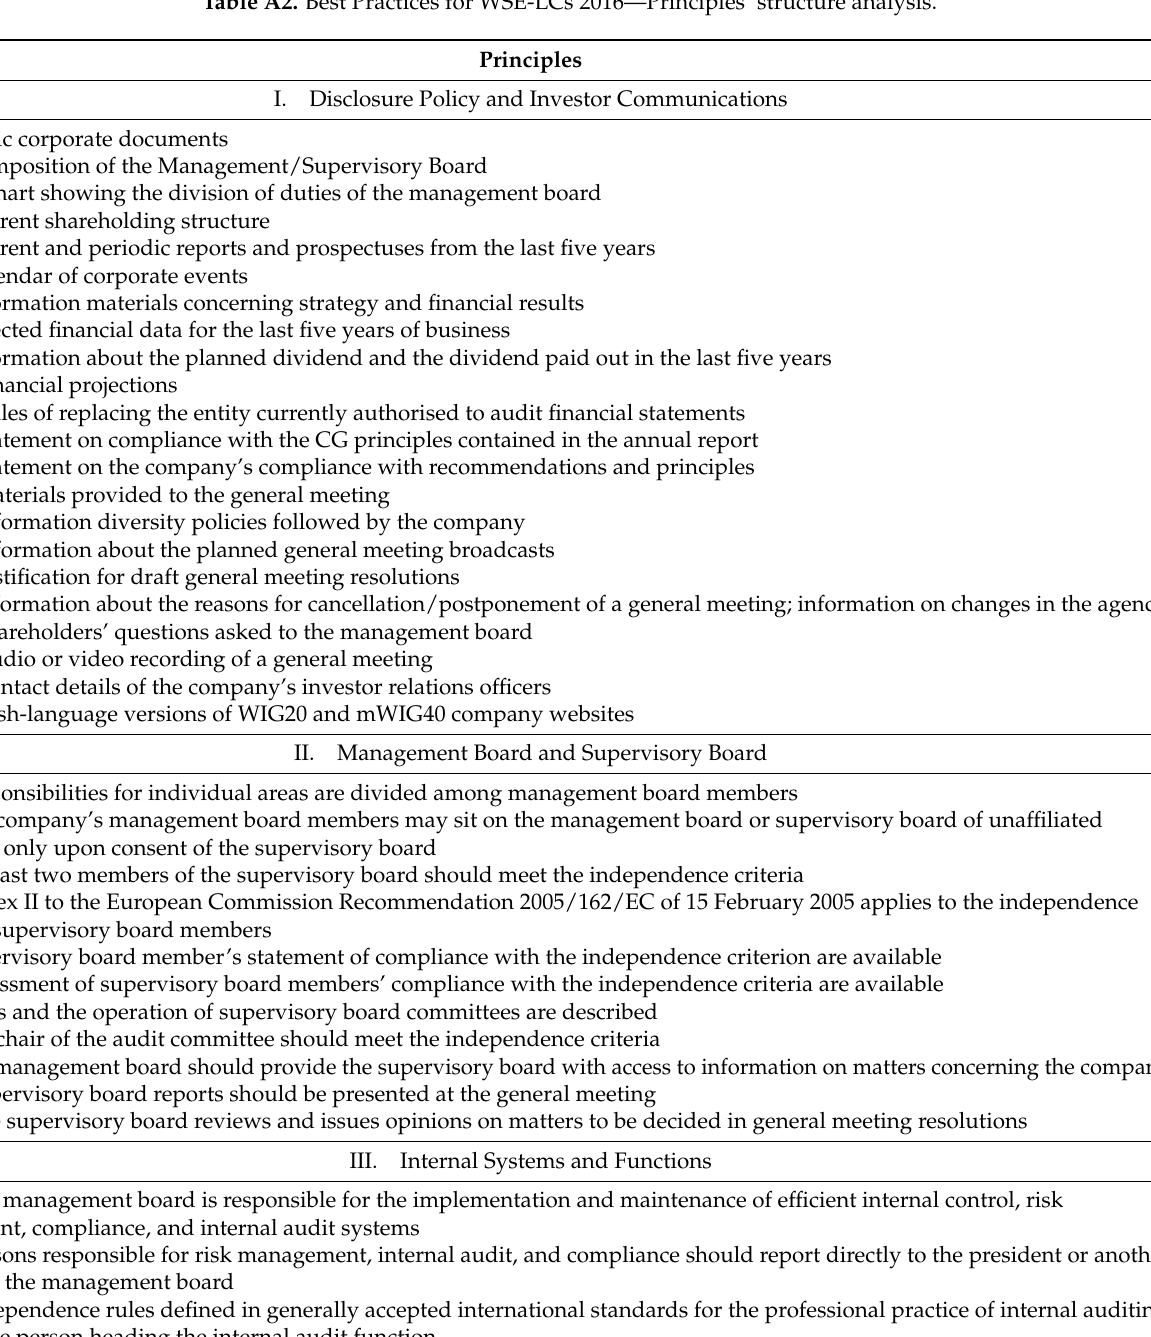
Table A2. Best Practices for WSE-LCs 2016—Principles’ structure